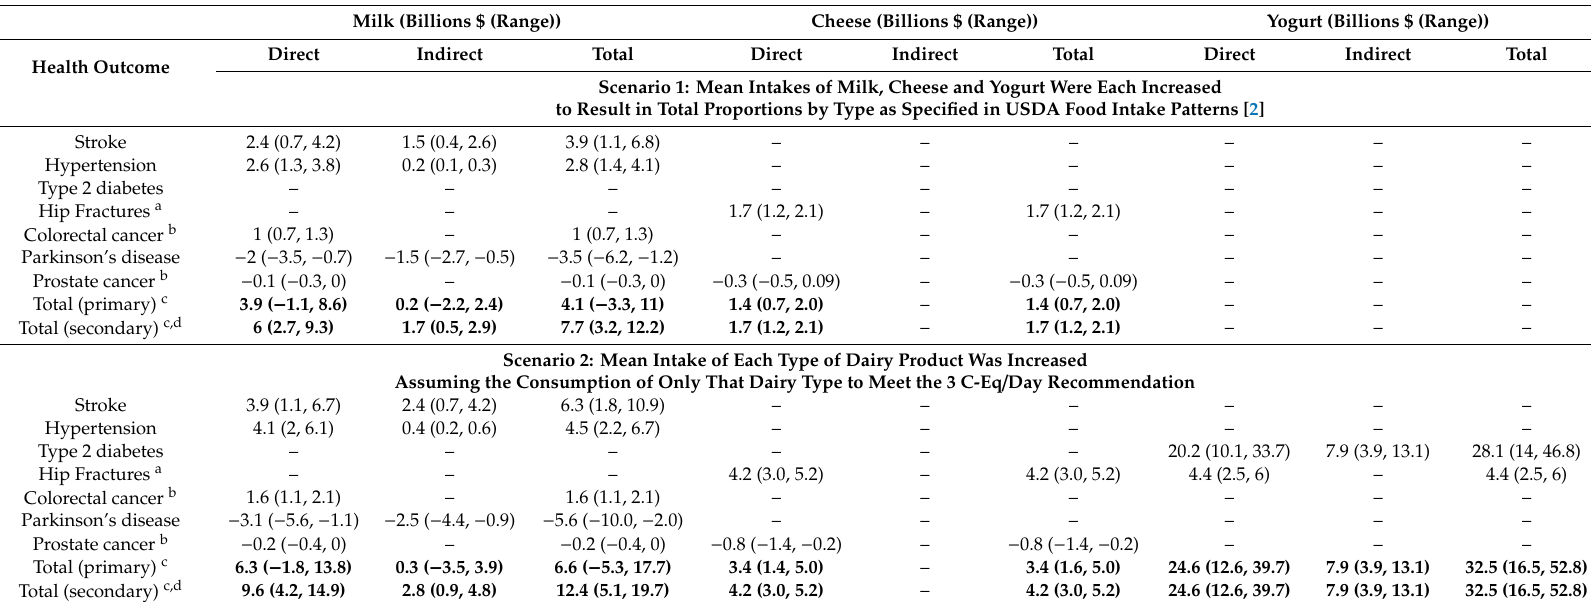
Table 6. Net annual change in health care costs (Billions $) associated with increasing milk, cheese, and yogurt consumption to meet the Dietary Guidelines for Americans (DGA) recommendation of 3 cup-equivalents / day among adults in the United